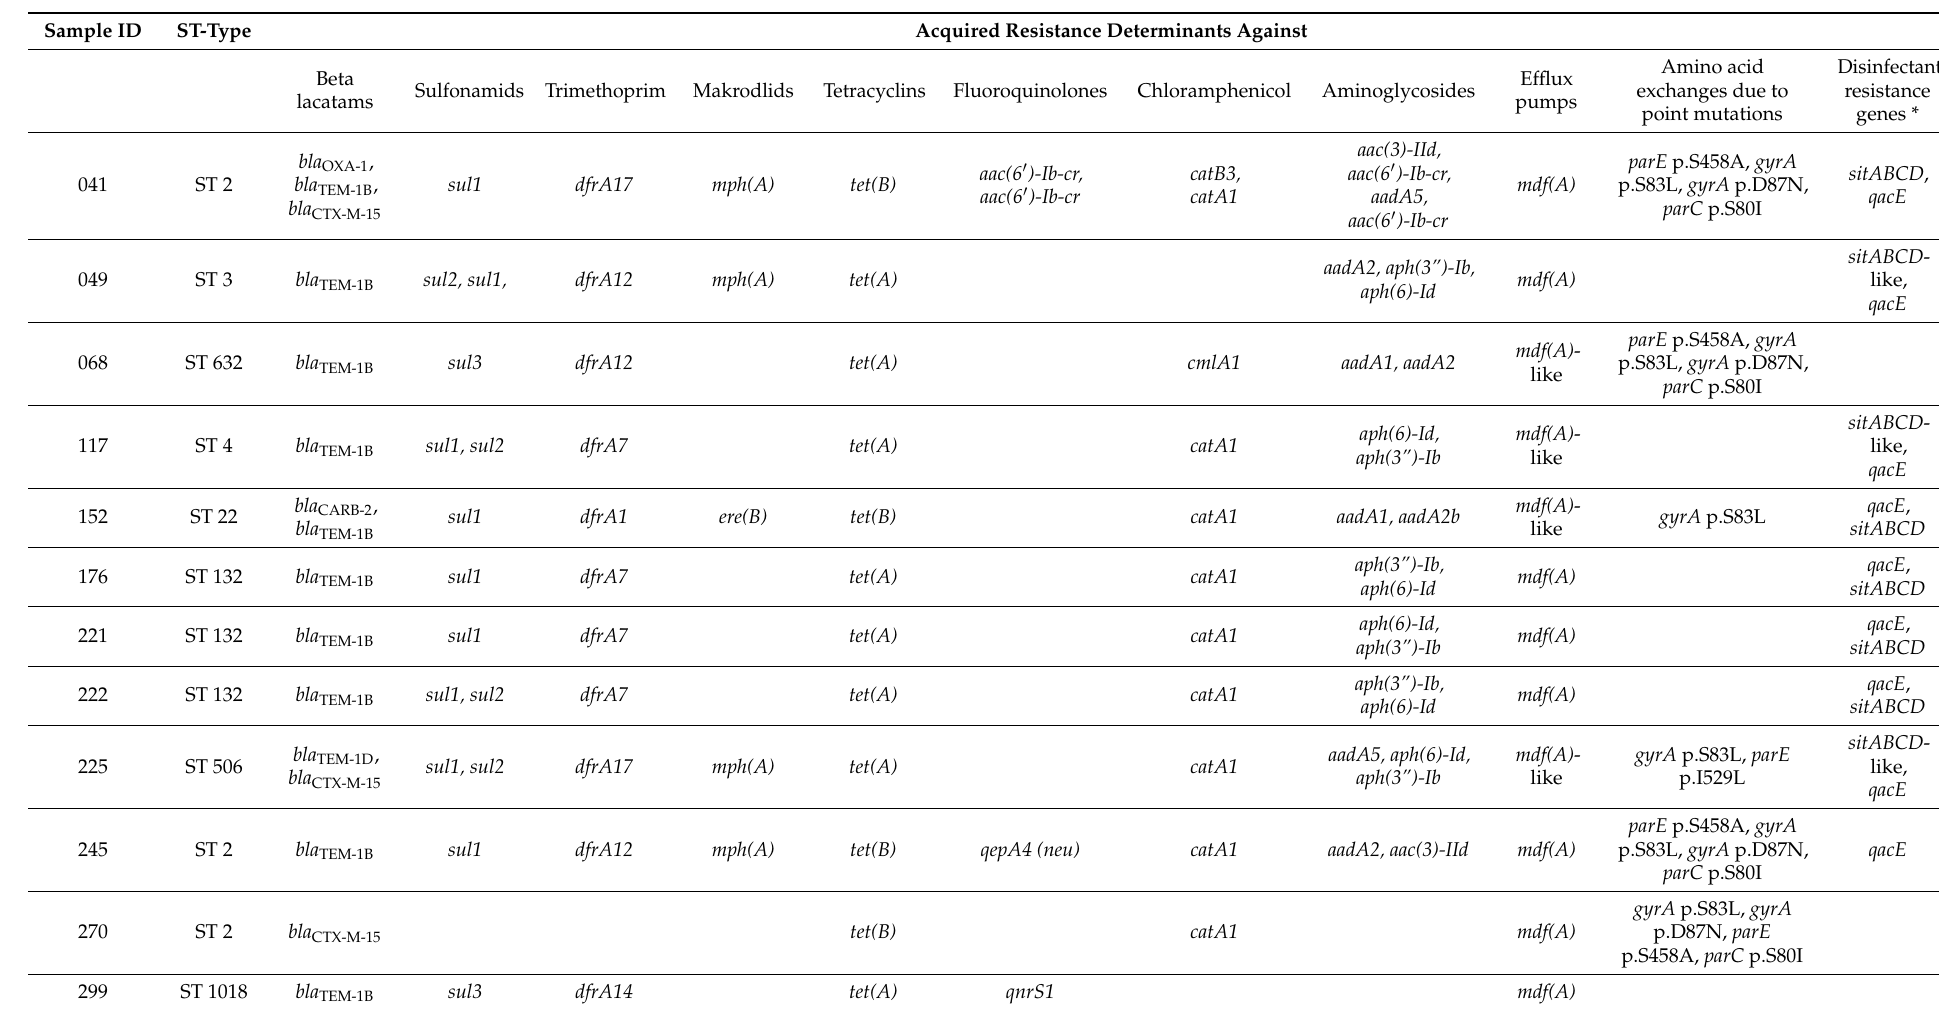
Table 1. Analysis of antimicrobial resistance determinants, ordered by strain and MLST type, of the assessed E. coli isolates. ST = Sequence